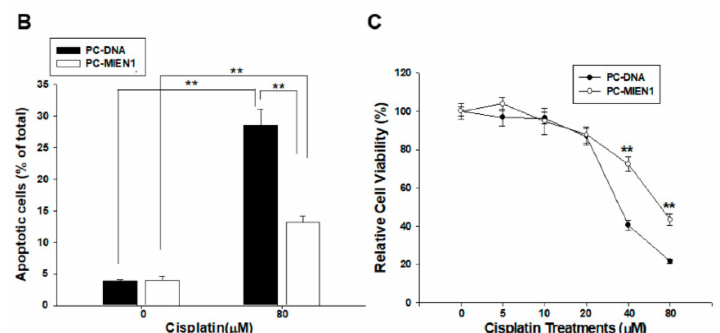
Figure 4. Overexpression of migration and invasion enhancer 1 (MIEN1) attenuates cisplatin-induced cell apoptosis in PC-3 cells. ( A ) Cells (PC-DNA and PC-MIEN1) were treated with or without 80 µ M cisplatin for 24 h. The fluorescence intensity for Annexin V-FITC in conjunction with PI staining was determined by flow cytometry ( ± standard error (SE), n = 4). ( B ) Data are presented as the percentage of apoptotic cells after cisplatin treatments. ( C ) Cell viability of PC-DNA and PC-MIEN1 cells after treatment with various dosages of cisplatin as indicated for 48 h ( ± SE, n = 8). ** p <